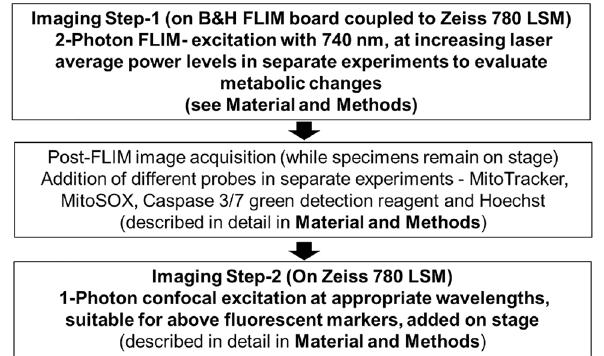
Figure 1. Flow Chart—2-step experimental strategy using a B&H FLIM board coupled to a Zeiss 780 LSM confocal, multiplexing multiphoton and confocal imaging. Following FLIM image acquisition (Step 1)